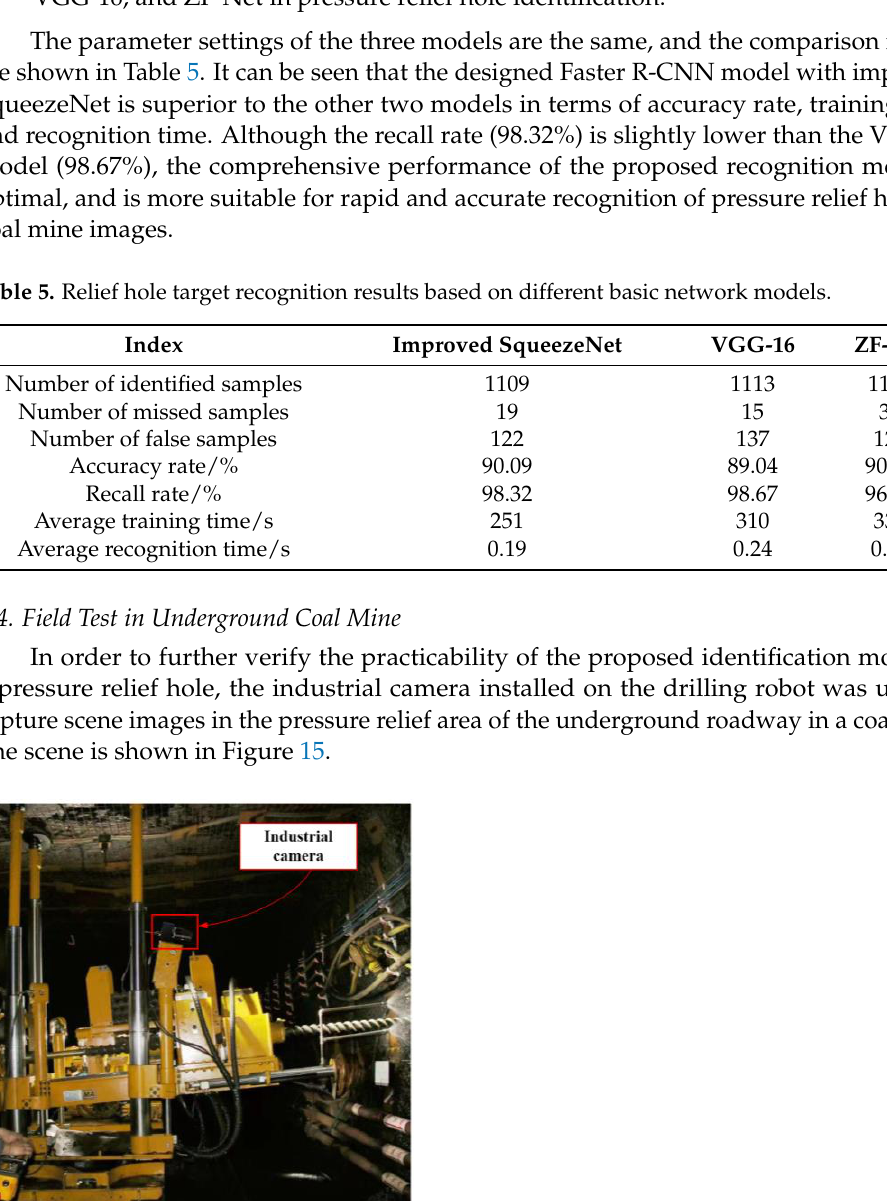
Table 5. Relief hole target recognition results based on different basic network models.